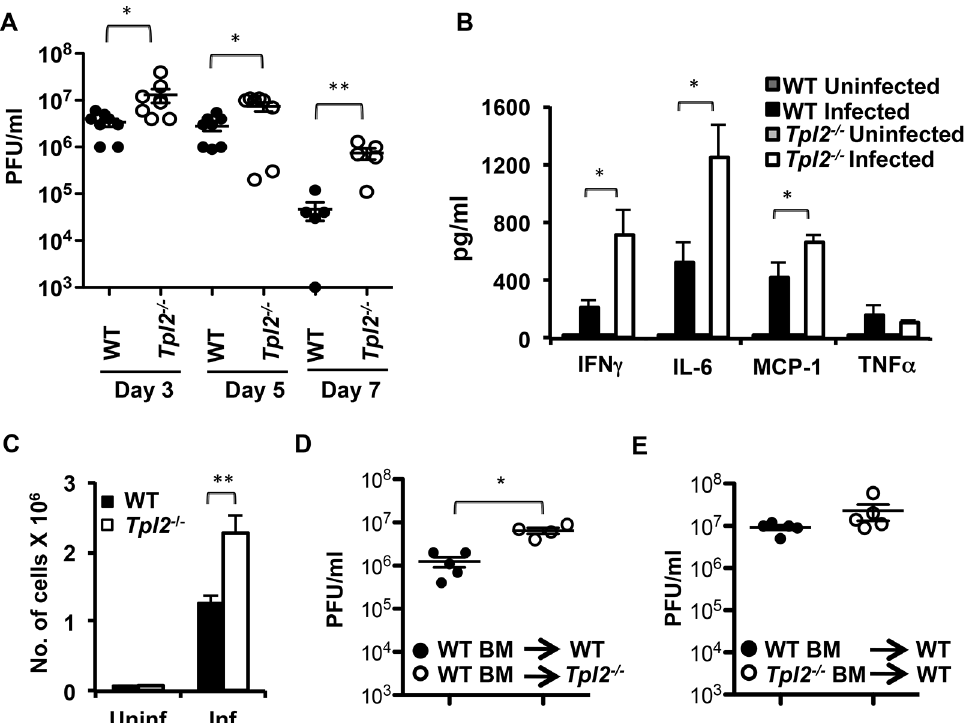
Fig 1. Tpl2 ablation enhances virus replication and inflammatory responses during influenza infection. (A) WT and Tpl2 -/- mice were intranasally infected with 10 4 pfu of X31 virus, and lung viral titers were enumerated by plaque assays; n = 8 (D3 and D5) or n = 5 (D7). WT and Tpl2 -/- mice were infected with 10 4 pfu of X31 virus, and the cytokine levels (B) and number of cells recovered (C) in BALF were measured on D7 pi; n = 6 uninfected and 10 (WT) and 8 ( Tpl2 -/- ) infected. (D-E) Chimeric mice were intranasally infected with 10 4 pfu of X31 virus, and lung viral titers were enumerated by plaque assays D3 pi. * indicates p < 0.05, ** indicates p <